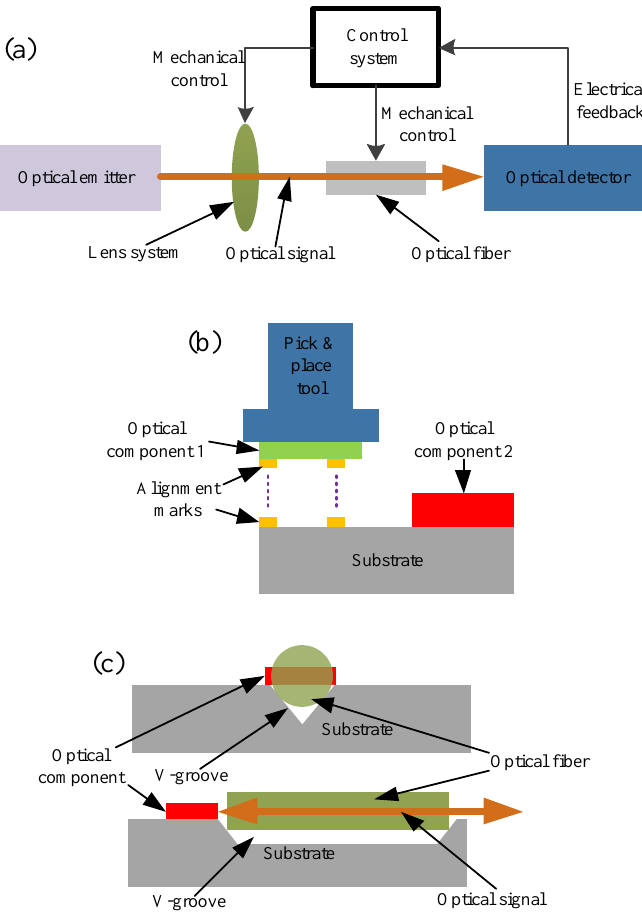
Figure 3. Schematic of optical alignment methods. ( a ) Close-loop active alignment; ( b ) Passive alignment using alignment marks; ( c ) Self-alignment using